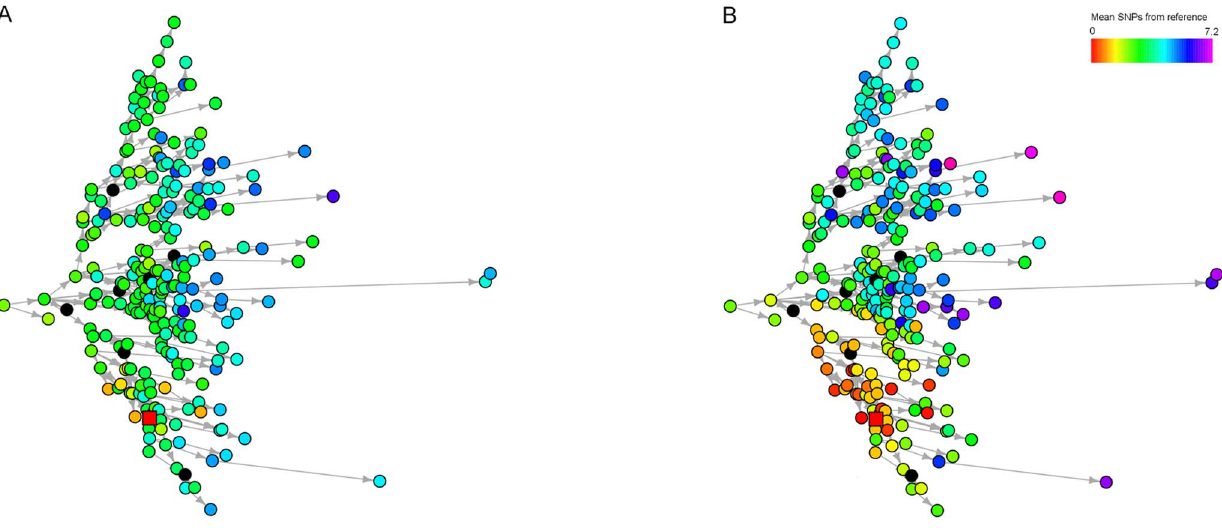
Figure 6. Simulated SIR epidemic in a population with 250 initial susceptibles and one infective with an initially clonal infection. A node was chosen at random during the epidemic (‘reference’, shown as a red square), and all other nodes are colored according to the observed mean genetic distance to the reference. ( A ) One isolate is sequenced from each individual. ( B ) Sampling occurs for all infectives every 100 generations. Data were simulated with a mutation rate m ~ 5 | 10 { 4 , transmission rate b ~ 3 | 10 { 4 and removal rate c ~ 1 | 10 { 4